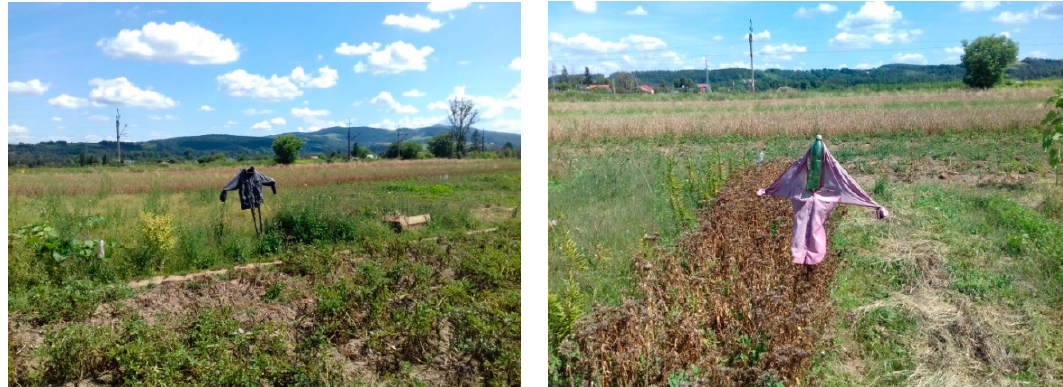
Figure 4. Scarecrows in a vegetable patch. Suburban farming. Near Stary S ˛acz (Małopolskie Voivodeship).